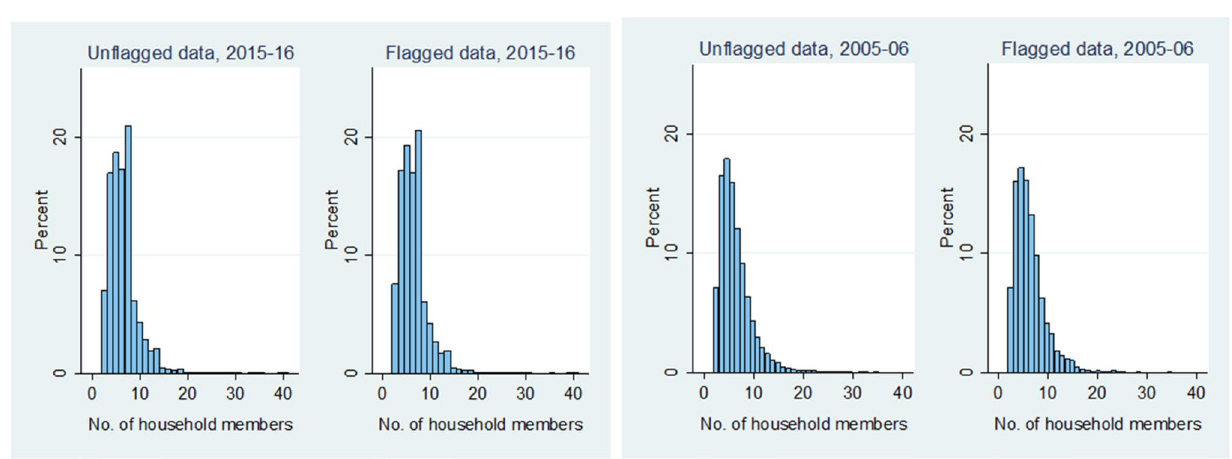
Figure 7. Differences in distribution of household members for flagged and unflagged